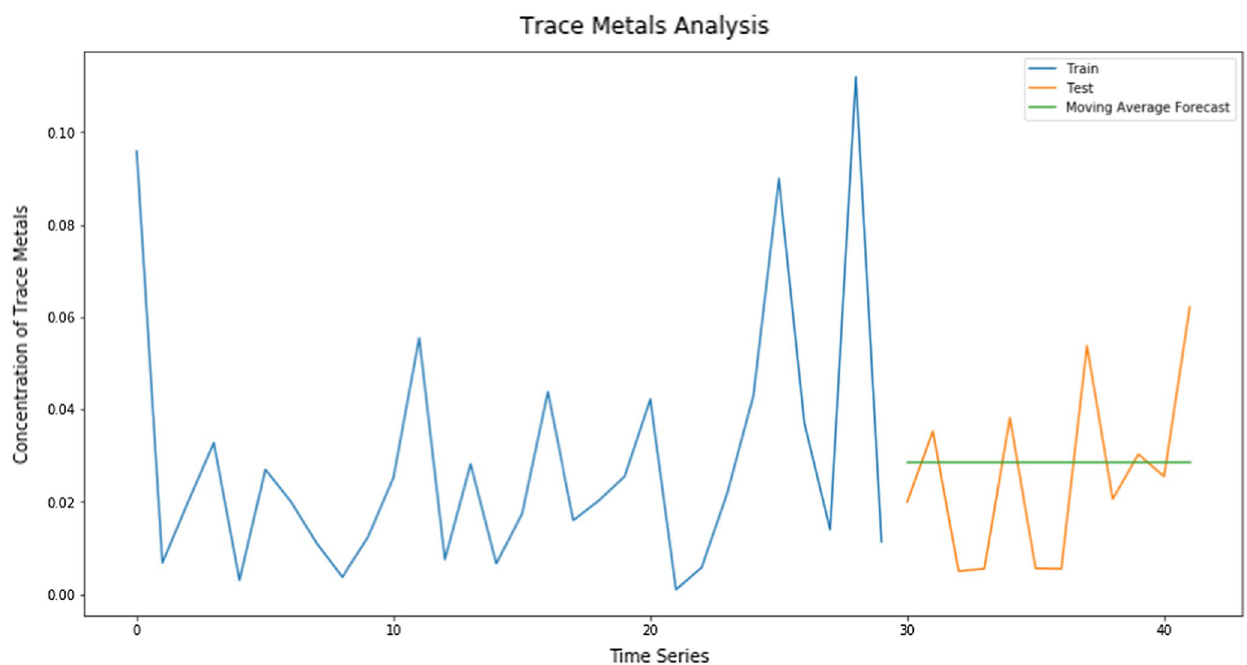
Fig. 7 Trace metals prediction using Moving Average forecast (machine learning with